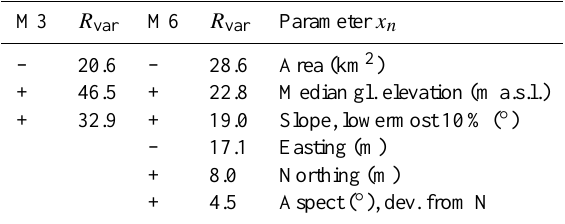
Table 2. The two parameter sets (M3, M6) used for the multiple re- gression analysis. The sign of the mass balance dependence on each variable is given. Explained variances r 2 are 35% for M3 and 51% for M6. The relative contribution R var (in %) of each variable to the total variance of the parameter set (taken as 100%) is evaluated by omitting one variable and comparing the reduction in r 2 with the original r 2